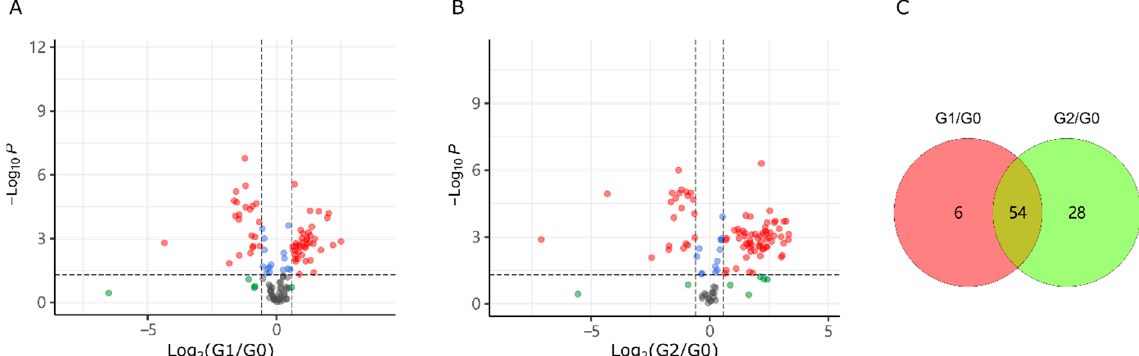
Figure 3. Metabolism variation induced by exposures with 1% ( A ) and 2% alcohol ( B ) and the number of differential metabolites ( C ). G1/G0, G1 vs. G0; G2/G0, G2 vs. G0. Table 1. Enrichment of differential metabolites invoked by alcohol (G2/G0 and